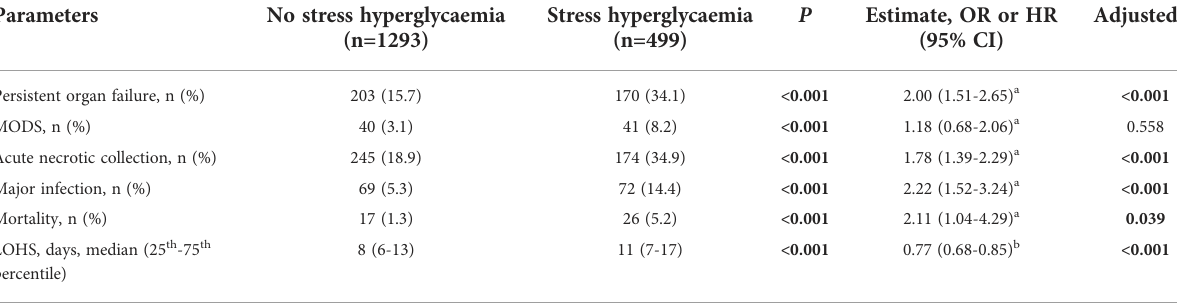
TABLE 2 Comparison of clinical outcomes with or without stress hyperglycaemia on admission.